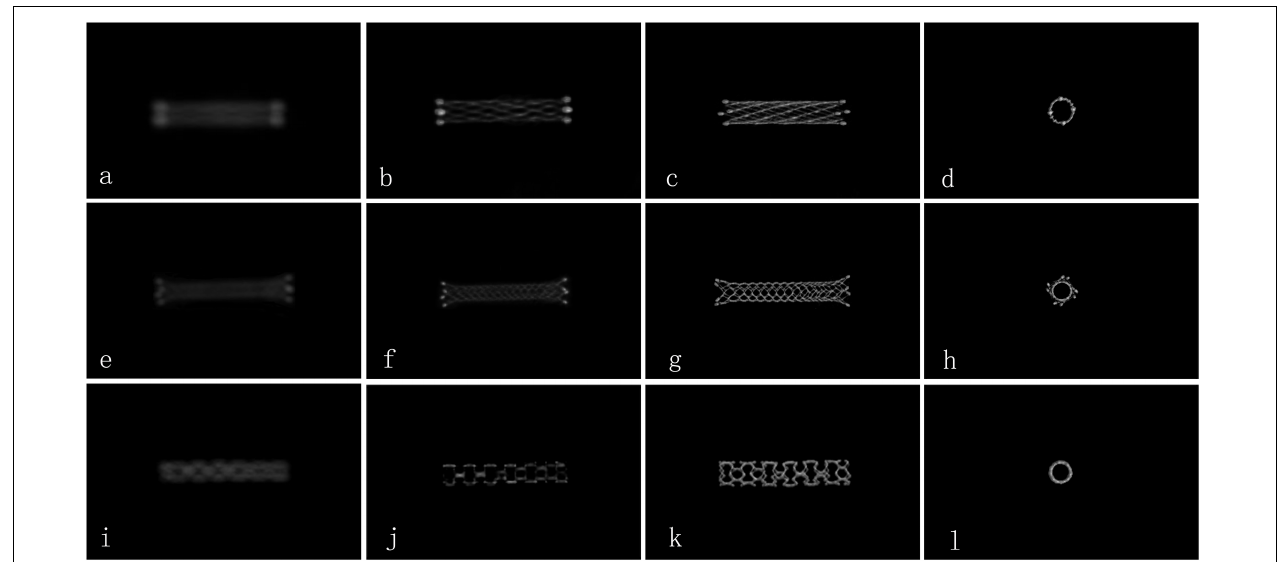
FIGURE 1 | Comparison of the image quality for different types of stents by FDCT and HR-FDCT in vitro (representative cases). (a–d) NeuroformTM EZ stent with image-quality scores of 0, 1, 2, and 2 points; (e–h) EnterpriseTM stent with image-quality scores of 0, 1, 2, and 2 points; (i–l) ApolloTM stent with image-quality scores of 0, 1, 2, and 2 points. Panels (a,e,i) were images by FDCT, and the rest were images by